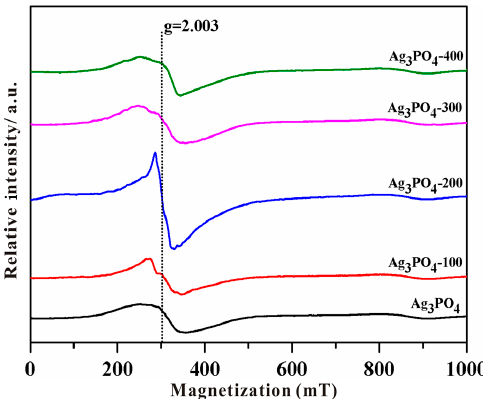
Figure 7. EPR spectra of pristine Ag 3 PO 4 and Ag 3 PO 4 -T (T = 100, 200, 300 and 400) recorded at room-temperature.